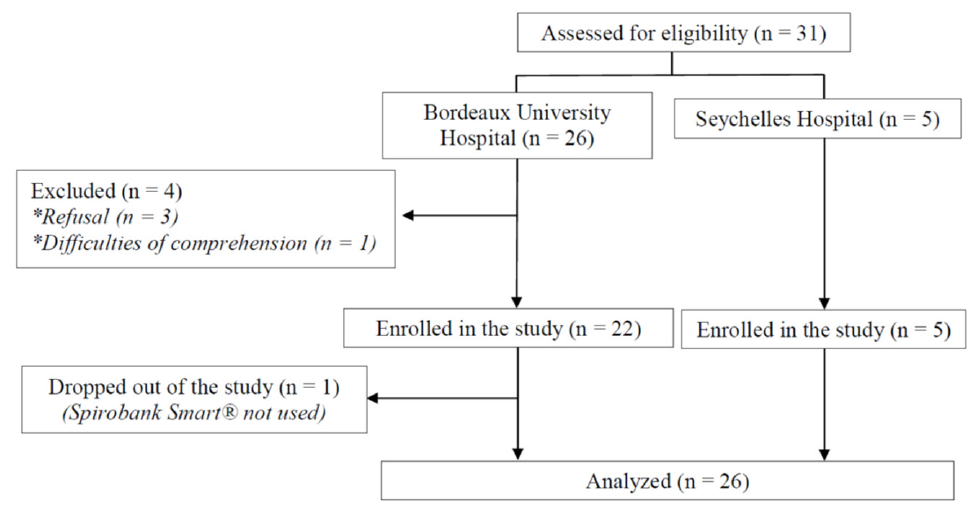
Figure 2. Study flow diagram. Demographic characteristics of the study population are shown in Table 1. Table 1. Demographic Characteristics of the Study Population.